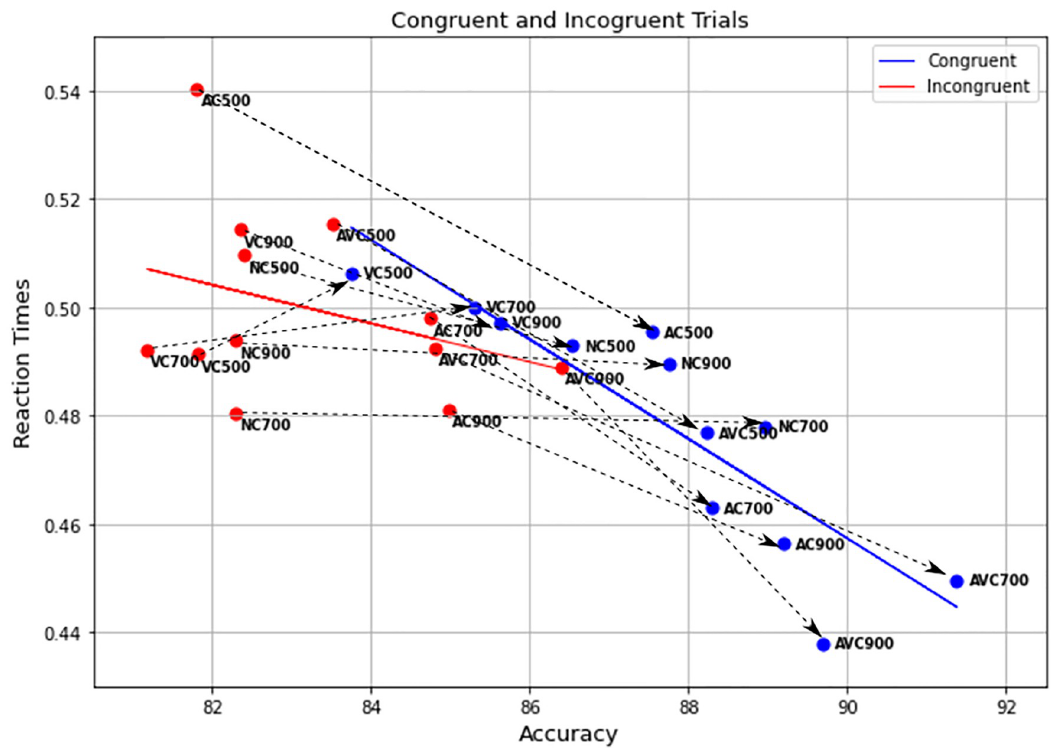
Fig 8. Accuracy in relation to RTs for each of the twelve different conditions, for congruent (blue) and incongruent (red) trials. Dashed arrows connect corresponding conditions in congruent and incongruent trials.